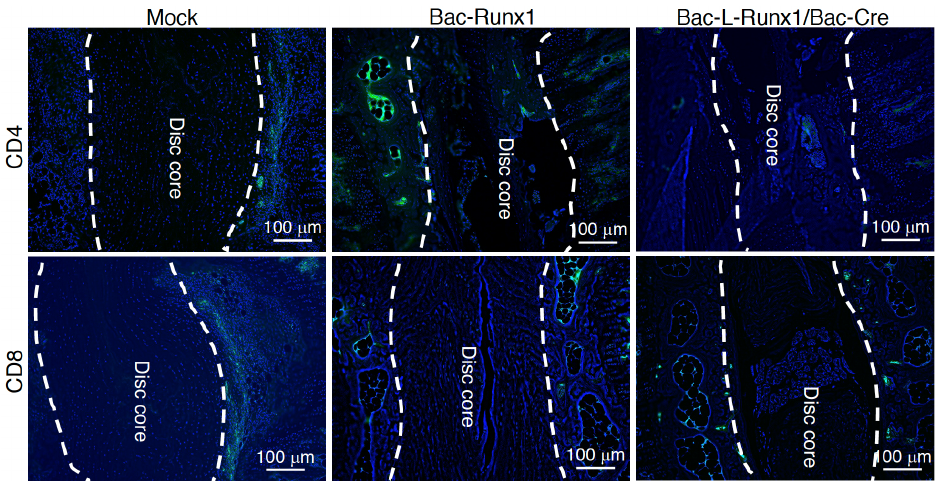
Figure 10. Adaptive immunity was evaluated by infiltration of CD4 + and CD8 + T cells. Traumatic disc transplanted with BMSCs genetically modified by Bac-L-Runx1/Bac-Cre were compared with Bac-Runx1 or mock-transduction. Representative images show the IHC staining using anti-CD4 and anti-CD8 1st antibodies, followed by 2nd antibody labeled with Alexa488, count-stained with DAPI. All groups were collected at 4 weeks post-transplantation. Dashed line circles the disc core matrix. ( n = 3).